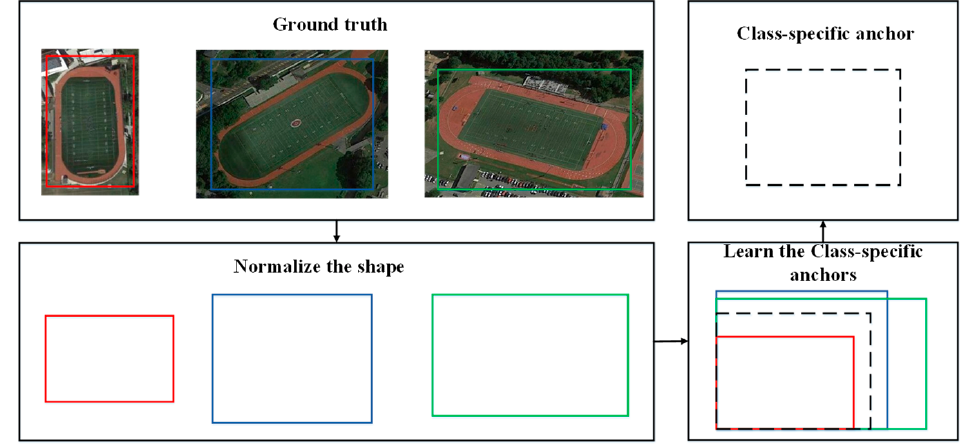
Figure 3. The sketch map of the process of calculating the class-specific anchors. Algorithm 1. The procedure of the class-specific anchor based region proposal network